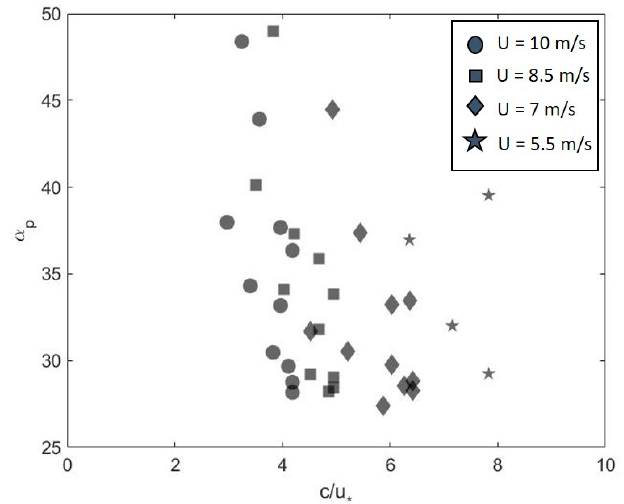
Figure 6. Atmospheric pressure coe ffi cient, α p , calculated based on β using Equation (20) for the irregular waves versus wave age.